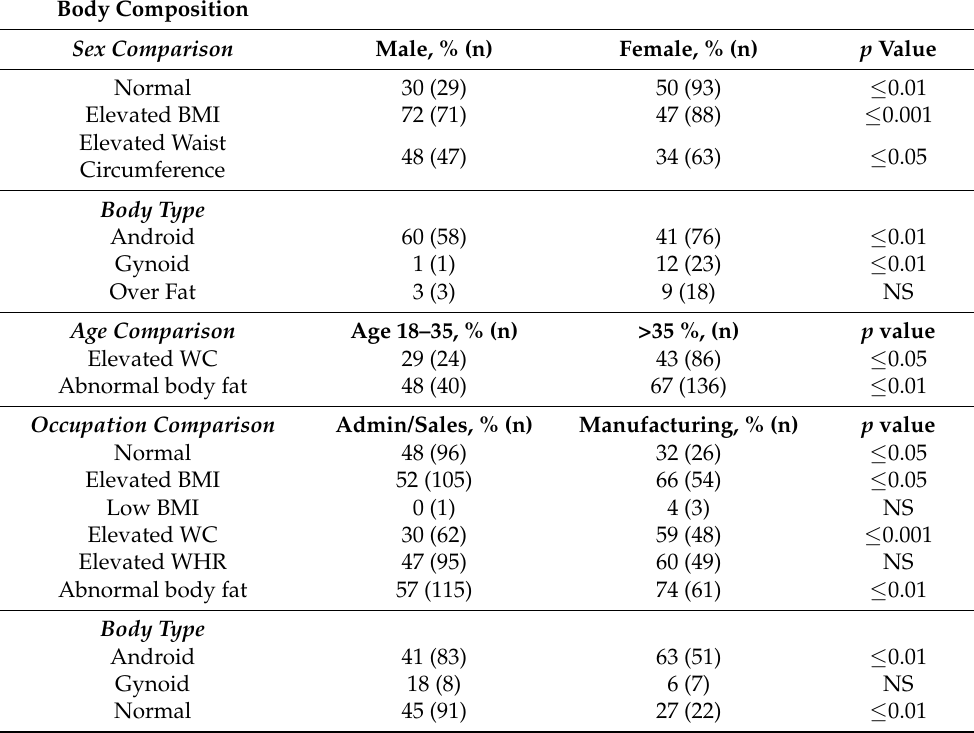
Table 4. Body Composition by Sex, Age,